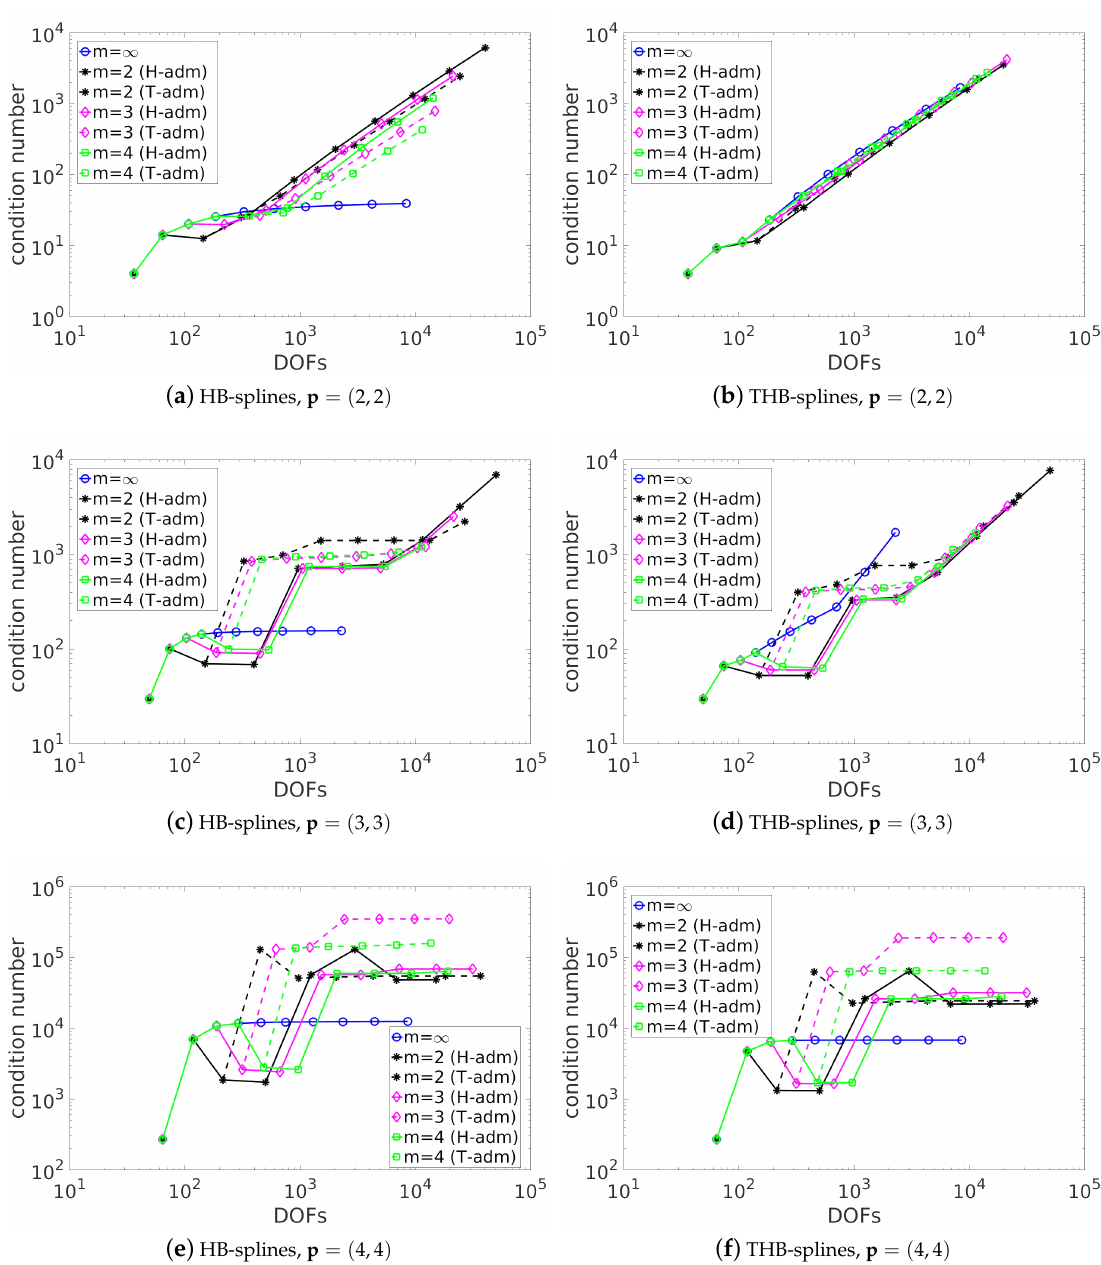
Figure 7. Condition numbers of the stiffness matrix for HB-splines and THB-splines, for different admissibility classes and different values of the